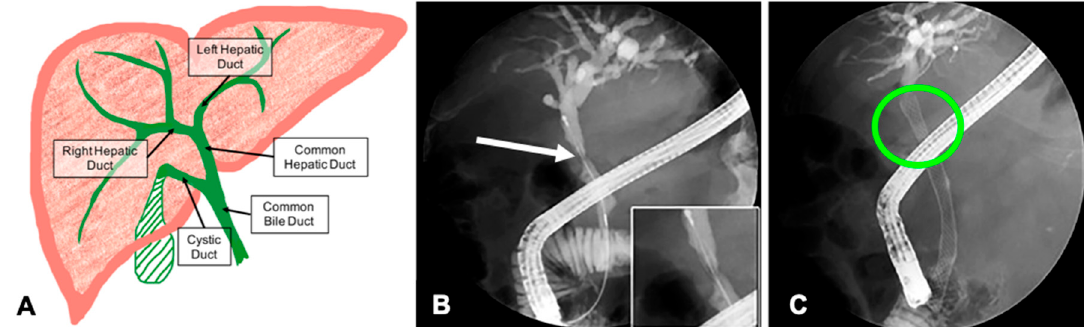
Figure 1. Hepatobiliary anatomy and cholestasis caused by a biliary stricture. ( A ) Anatomically, the extrahepatic ducts begin at the left and right hepatic ducts. They merge to form the common hepatic duct that connects to the gall bladder via the cystic duct. Bile drains into the small intestine through the common bile duct. ( B ) A significant stricture of the common hepatic duct (CHD) viewed during an endoscopic retrograde cholangiopancreatography (ERCP). The stent catheter has been threaded through the stricture. ( C ) A SEM stent was deployed to open the stricture and alleviate the cholestasis. ( B and C modified with permission from [17]).